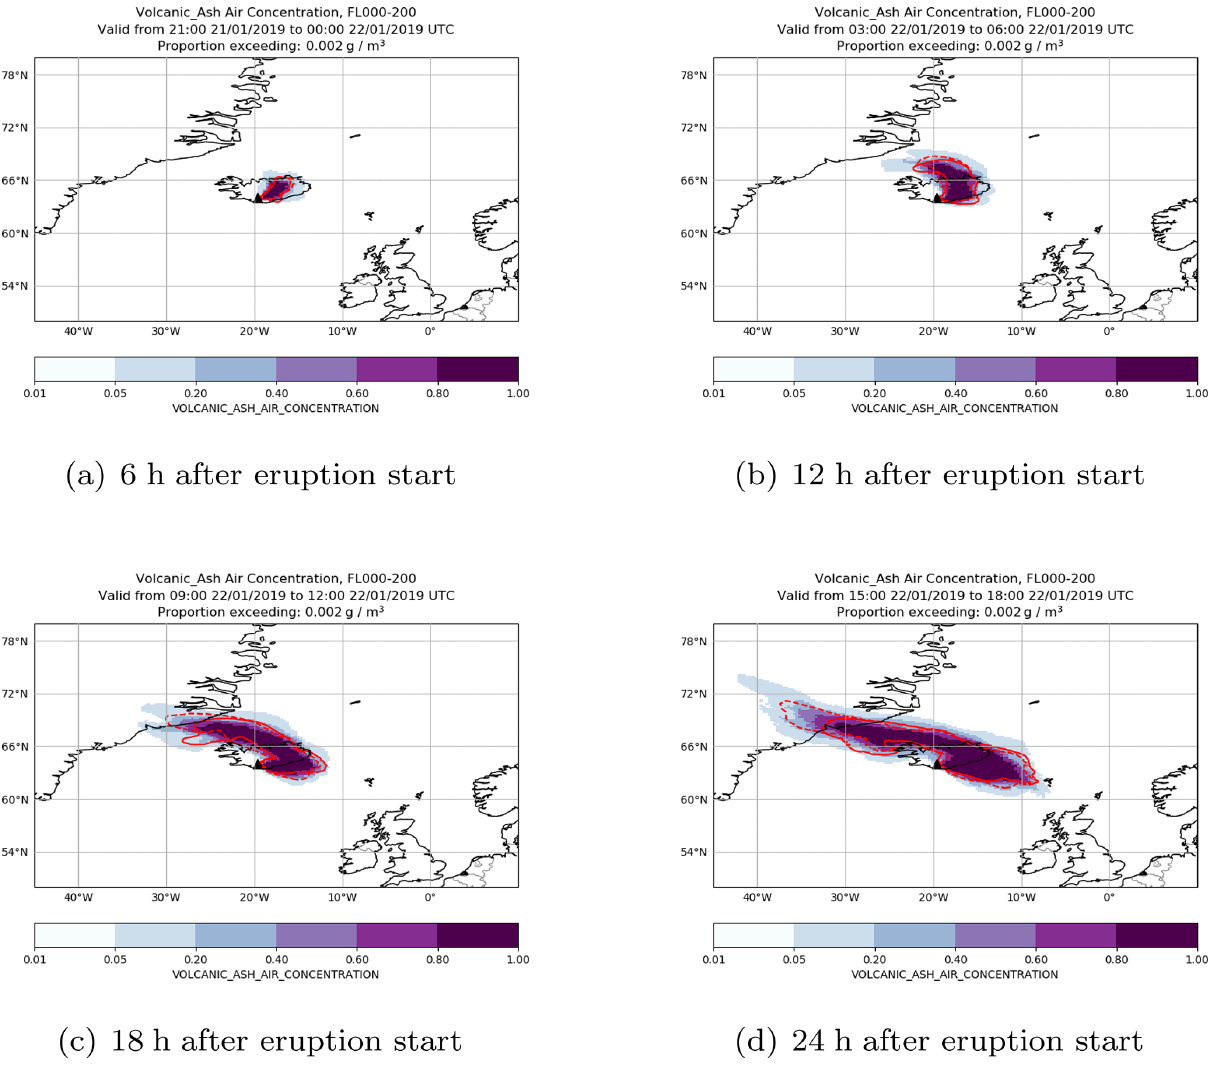
Figure 10. A volcanic ash simulation of Hekla where the Brier skill score is high for concentrations exceeding 2mgm − 3 at FL000-200. The coloured contours show the probability of the ensemble predictions exceeding the threshold in 6h time steps starting 6h after the eruption. The area where the threshold is exceeded by the analysis simulation is shown by a red solid line and the area where the threshold is exceeded for the deterministic simulation by a red dashed